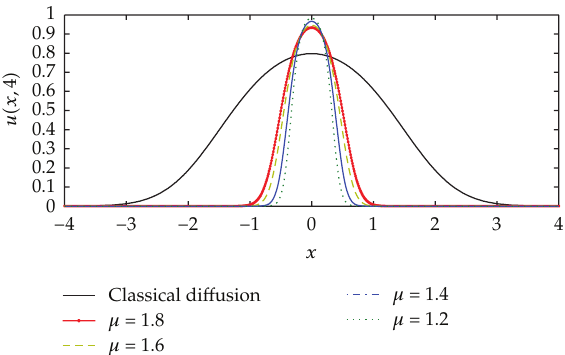
Figure 5: Numerical solutions at t (cid:8) 4 for (cid:3) 5.5 (cid:5) and (cid:3) 5.10 (cid:5) with λ (cid:8)